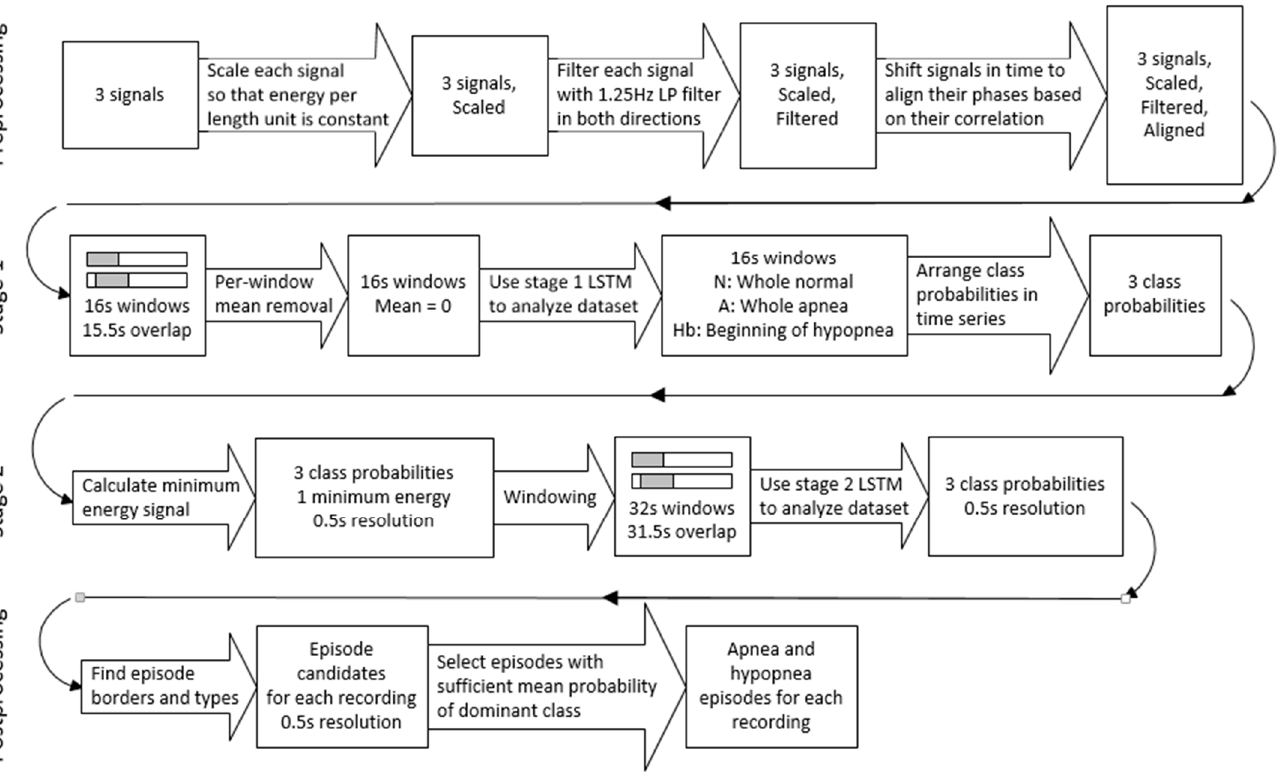
Figure 1. Block diagram of the proposed architecture.